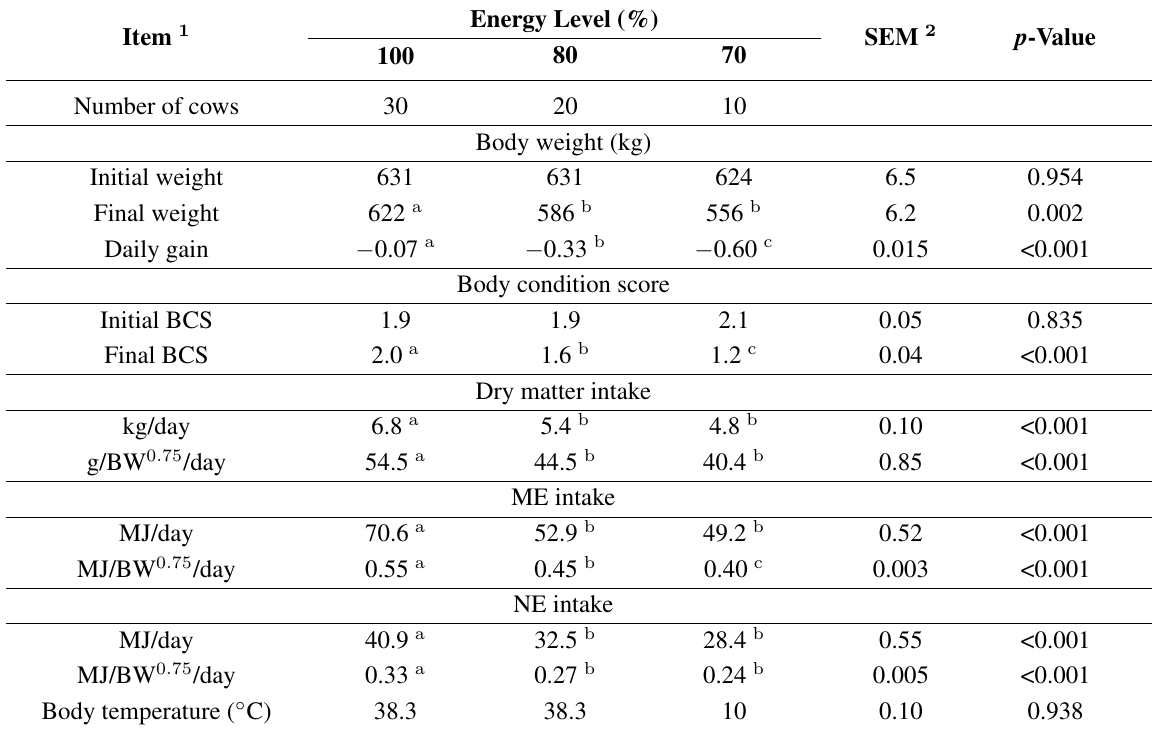
Table 2. Effect of energy level on body weight and condition, energy intake